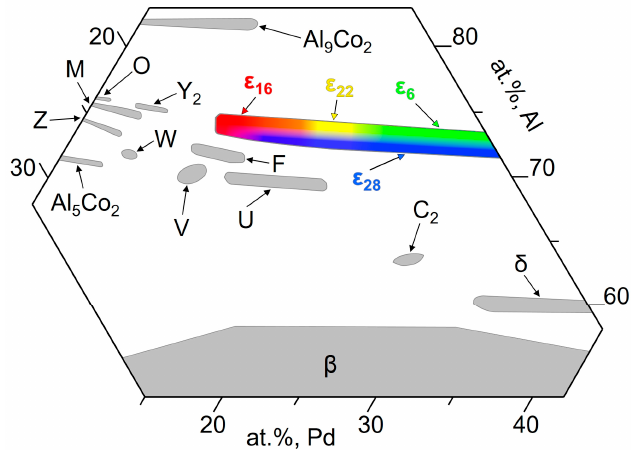
Figure 6. Schematic positions of binary and ternary phases in the isothermal section of a partial Al–Pd–Co diagram, redrawn from Reference [3]. For the color interpretation of this figure, the reader is referred to the web version of this